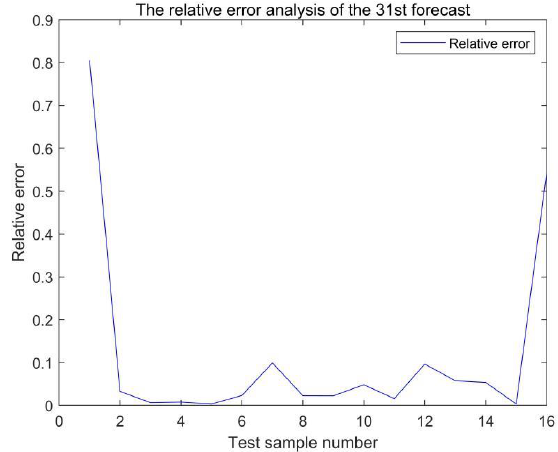
Figure 39. The relative error plot of the prediction set.